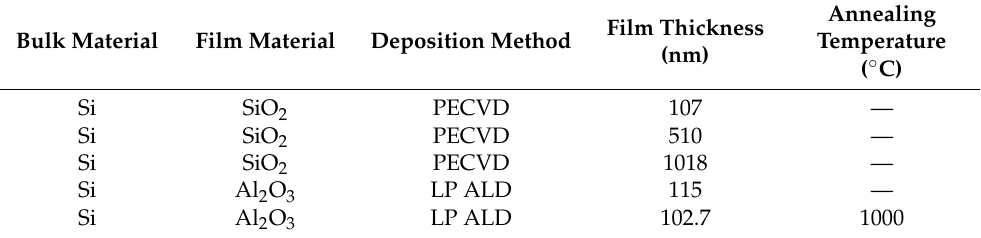
Figure 3. Scanning electron microscope (SEM) image of a cross-section of Al 2 O 3 thin film samples ( A ) without annealing and ( B ) with annealing at 1000 °C. Table 3. Overview of all sample materials, deposition methods, film thicknesses, and annealing temperatures .